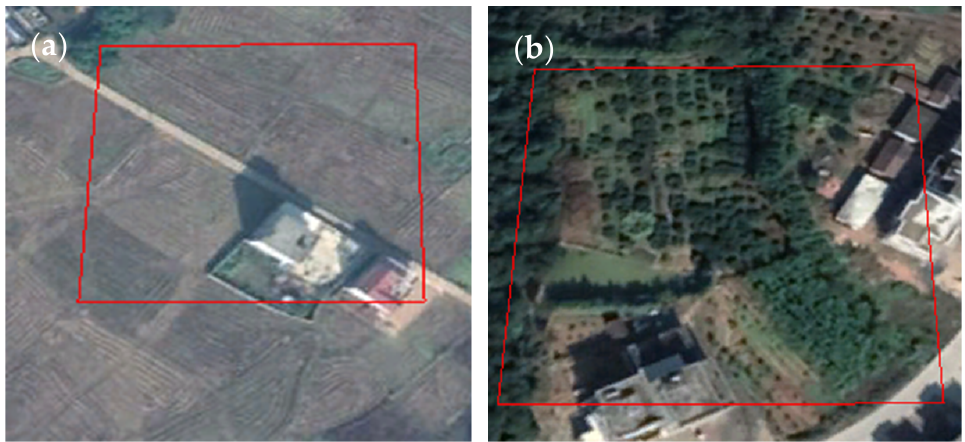
Figure 8. Illustration of validation criteria using two samples displayed in ( a ) and ( b ).